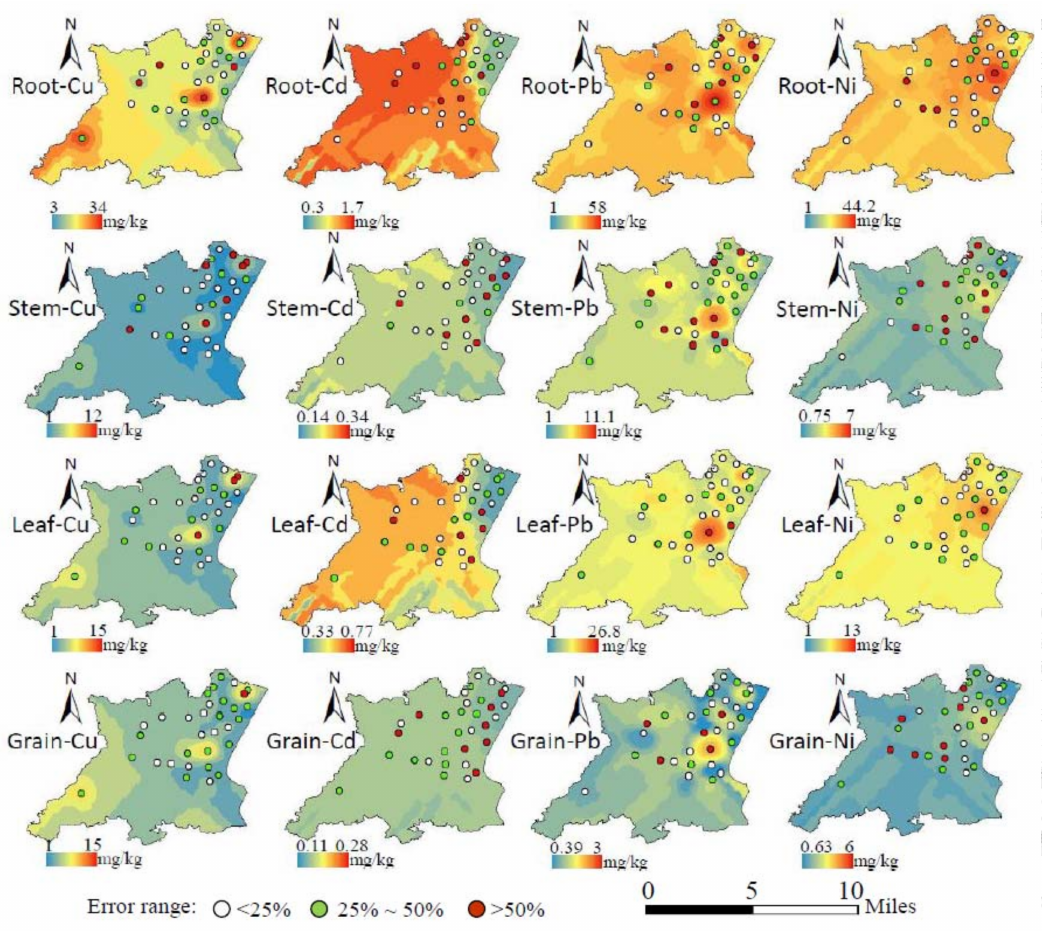
Figure 9. Risk evaluation of trace metals pollution in